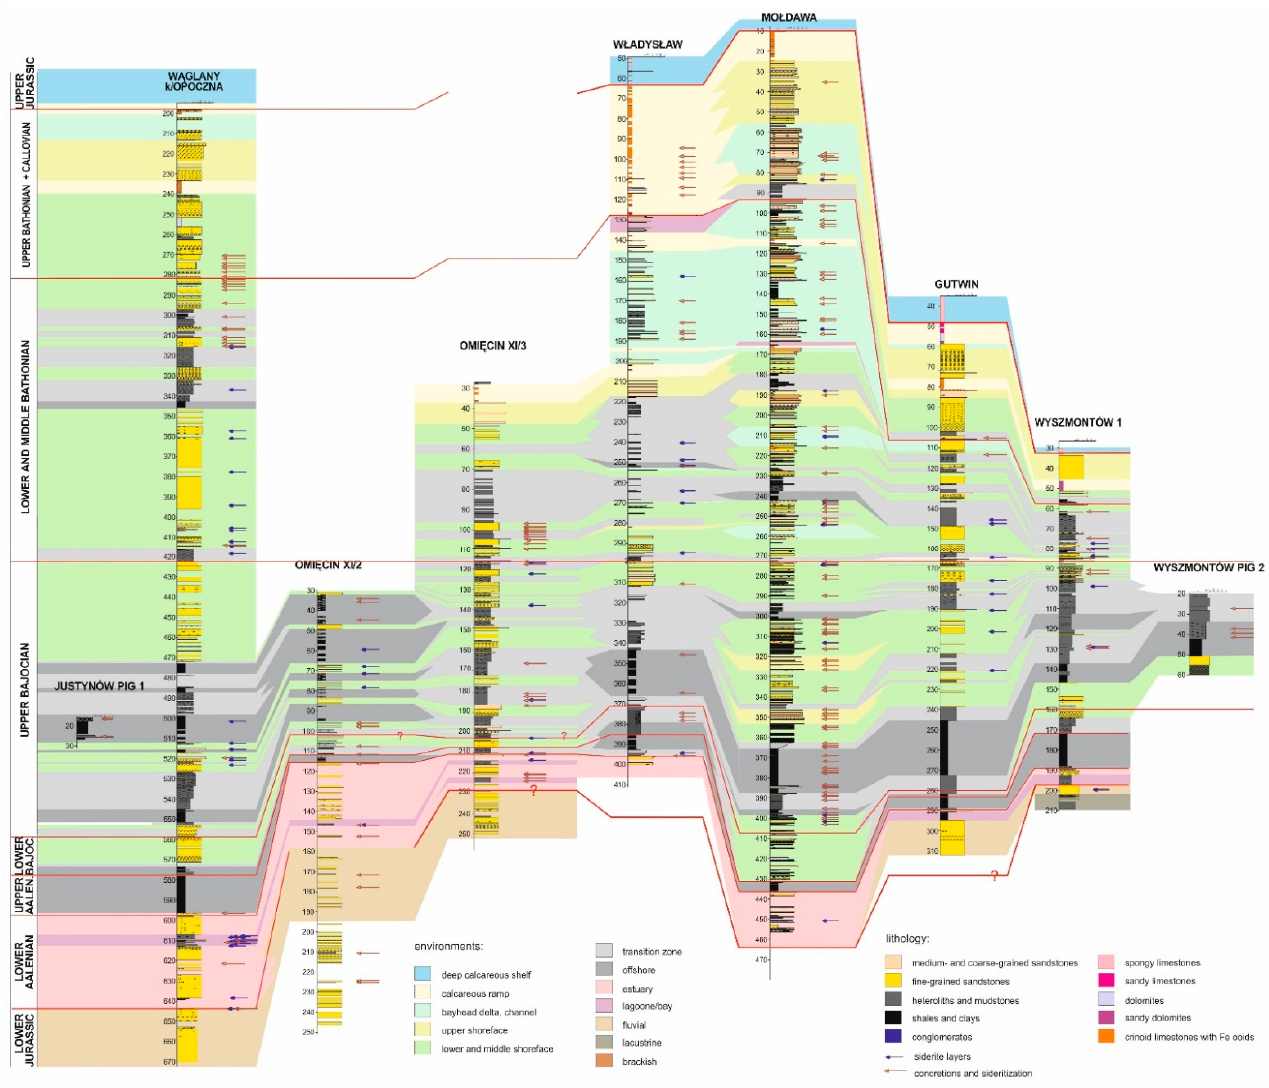
Figure 7. Correlation of the Middle Jurassic sediments between studied boreholes.